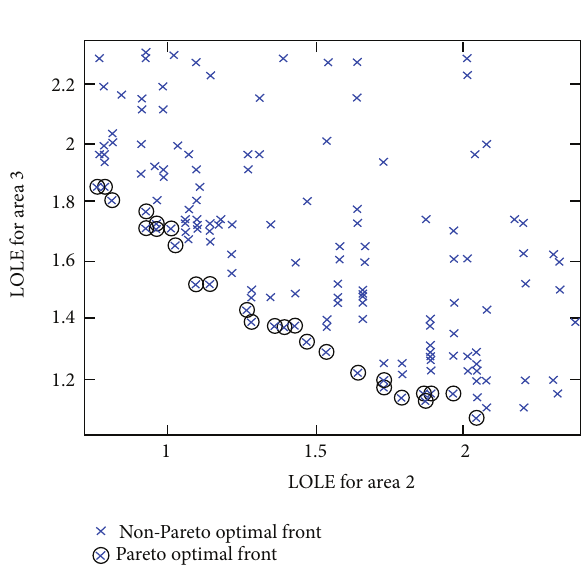
Figure 6: Pareto optimal fronts of LOLE for areas 2 and